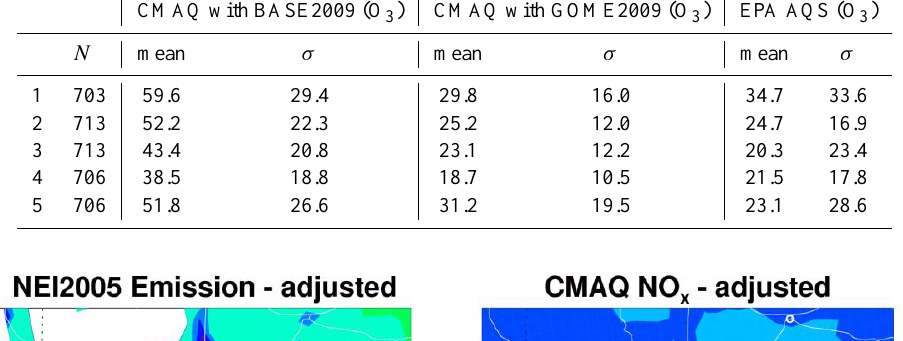
Table 3. The total number, the mean, and the standard deviation of the EPA AQS NO x observations (inppbv), CMAQ NO x simulations with the baseline emissions, BASE2009 and CMAQ NO x simulations with GOME-2 adjusted emissions, GOME2009 at the five EPA AQS NO x measurement sites (see the right panel of Fig. 3, 1: Los Angeles, 2: South Pasadena, 3: Anaheim, 4: La Habra, and 5: Riverside). CMAQ with BASE2009 (O 3 ) CMAQ with GOME2009 (O 3 )